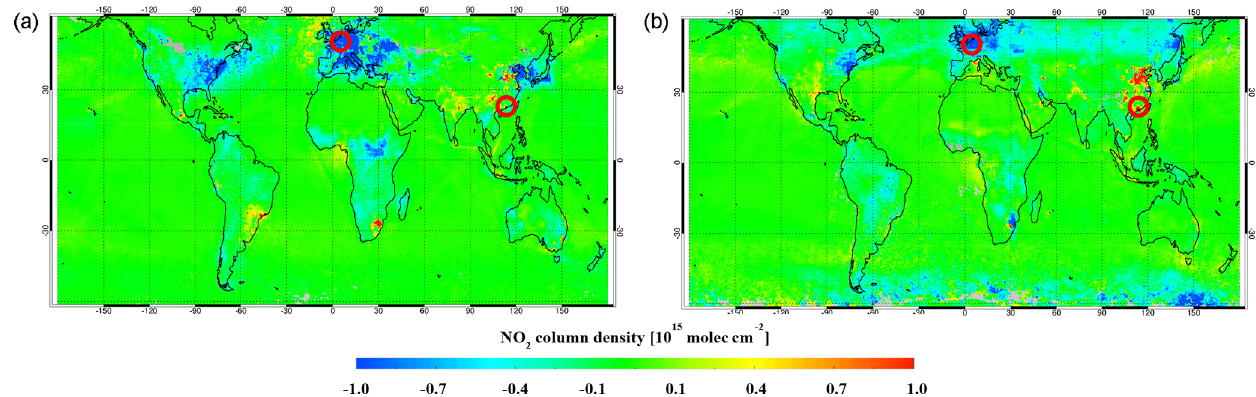
Figure 13. Difference in tropospheric NO 2 columns for clear-sky conditions (cloud radiance fraction smaller than 0.5) retrieved using daily TM5-MP and monthly MOZART-2 a priori NO 2 profiles for February (a) and August (b) 2009. Red circles indicate locations in Fig.